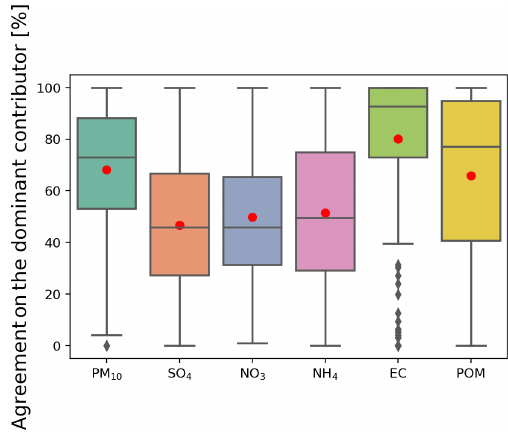
Figure 9. Agreement on the determination of the dominant country contributor for PM 10 , SO 4 , NO 3 , NH 4 , EC, and POM in percent, determined over all of the studied cities using the nine grid cells definition and for all 4d forecasts. The line that divides the box into two parts represents the median of the data. The ends of the box show the upper and lower quartiles. The extreme lines show the highest and lowest values excluding outliers, which are represented by grey diamonds. The red dots correspond to the mean of each data